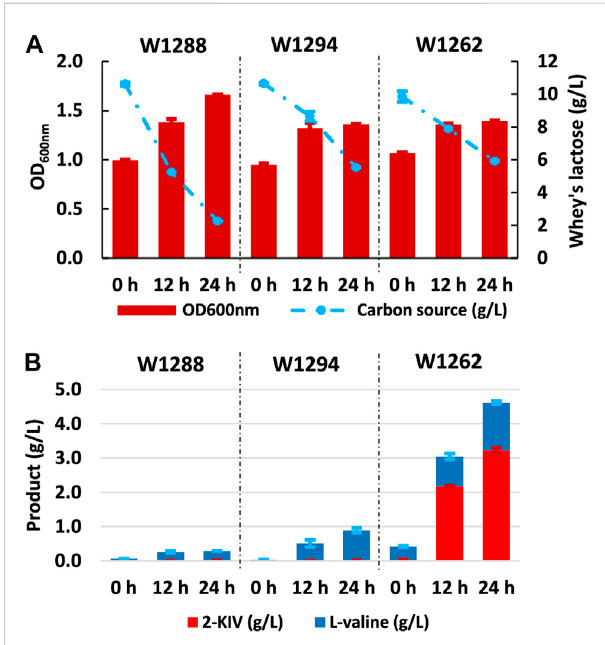
FIGURE 9 Kinetic of growth, substrate uptake and production of 2- ketoisovalerate and L-valine with E. coli W1288, E. coli W1294 and E.coli W1262inshake fl askexperimentsusingwhey ’ slactose.Biomass production and carbon source uptake (A) , biosynthesis of products (B) . Error bars indicate the difference between replicate